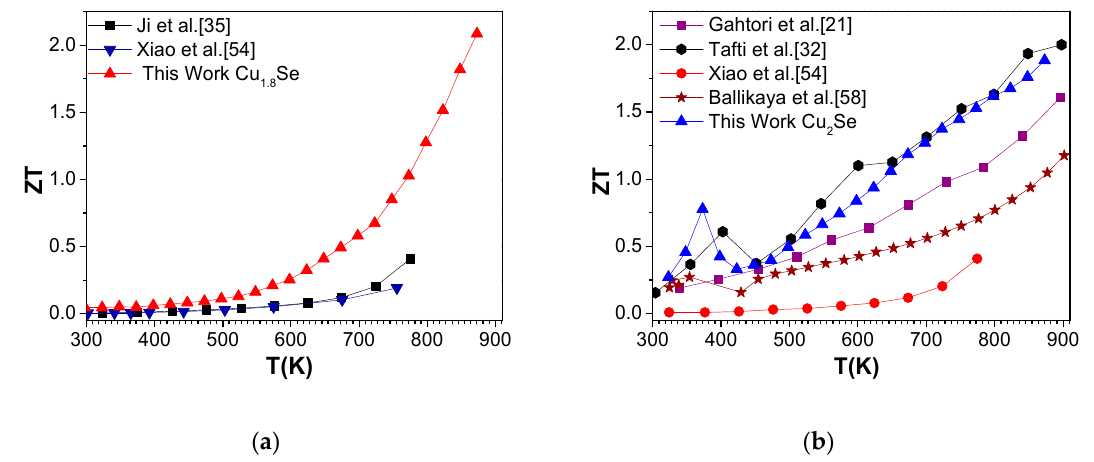
Figure 9. ZT values of ( a ) Cu 1.8 Se and ( b ) Cu 2 Se samples in this work plotted against the earlier data reported for the materials with the same composition. The non-monotonous behavior of measured quantities in the temperature range of 300–400 K in ( b ) is due to the structural phase transition of Cu 2 Se [58].